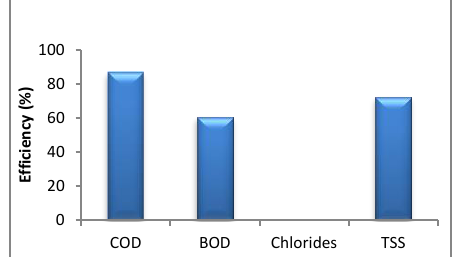
Figure 3: Removal Efficiency of Facultative Pond